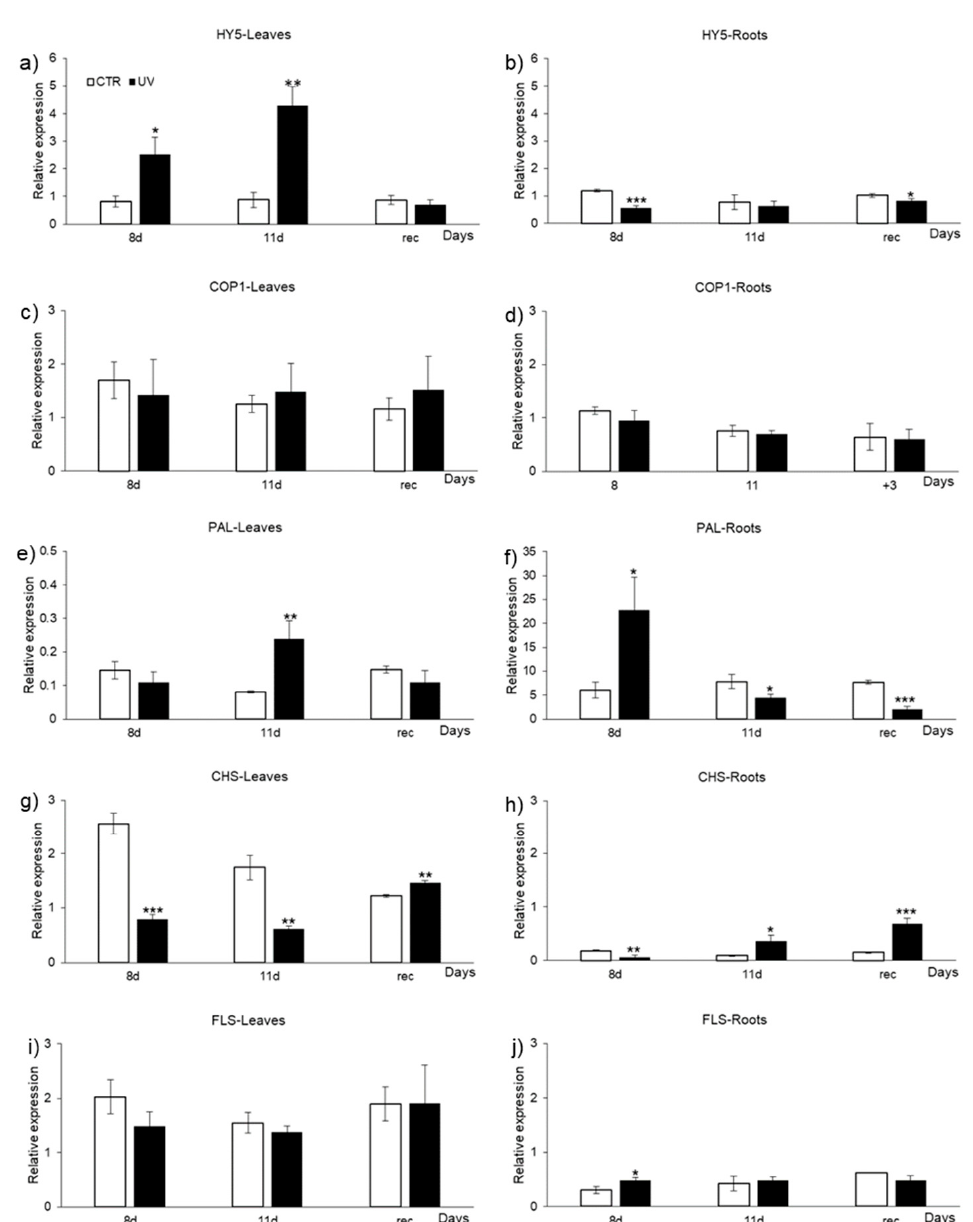
Figure 6. Expression levels of genes involved and in the UVR8 pathway (HY5, COP1) and in phenolic biosynthesis (PAL, CHS, FLS) in ( a , c , e , g , i ) leaves and ( b , d , f , h , j ) roots of control (CTR) and UV-treated (UV) Micro-Tom tomato plants after 8 and 11 days of UV treatment (8 d and 11 d) and after 3 days from the end of the irradiation (rec). Data are mean ± SE of 3 biological replicates. According to each day, asterisks (*) indicate a significant difference between CTR and UV group (* p ≤ 0.05, ** p < 0.01, *** p < 0.001).